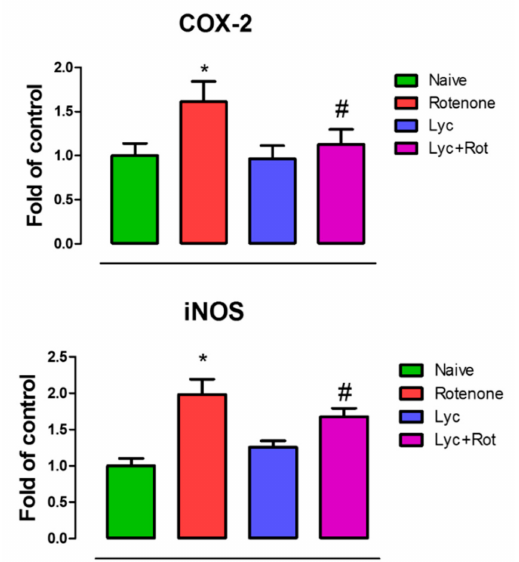
Figure 7. Immunoblotting analysis of Cox-2 and iNOS. Immunoblots of midbrain protein samples probed with Cox-2 and iNOS ( A ). Quantitative analysis of COX-2 and iNOS western blots were shown in histogram B and C, respectively. Values are expressed as mean ± SEM. * p < 0.05 compared to control, # p < 0.05 compared to the rotenone-treated